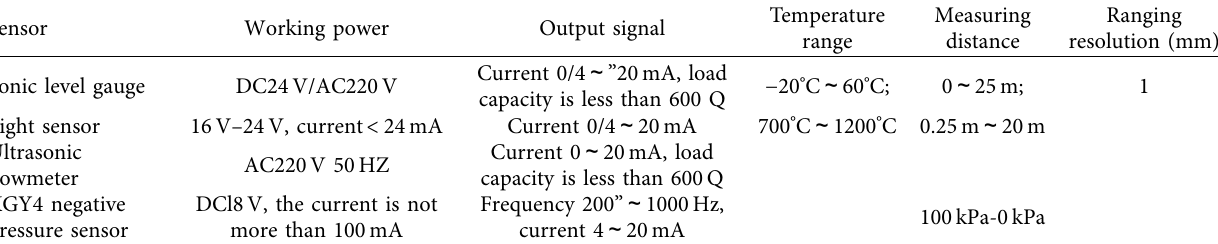
Table 1: Sensor type and model